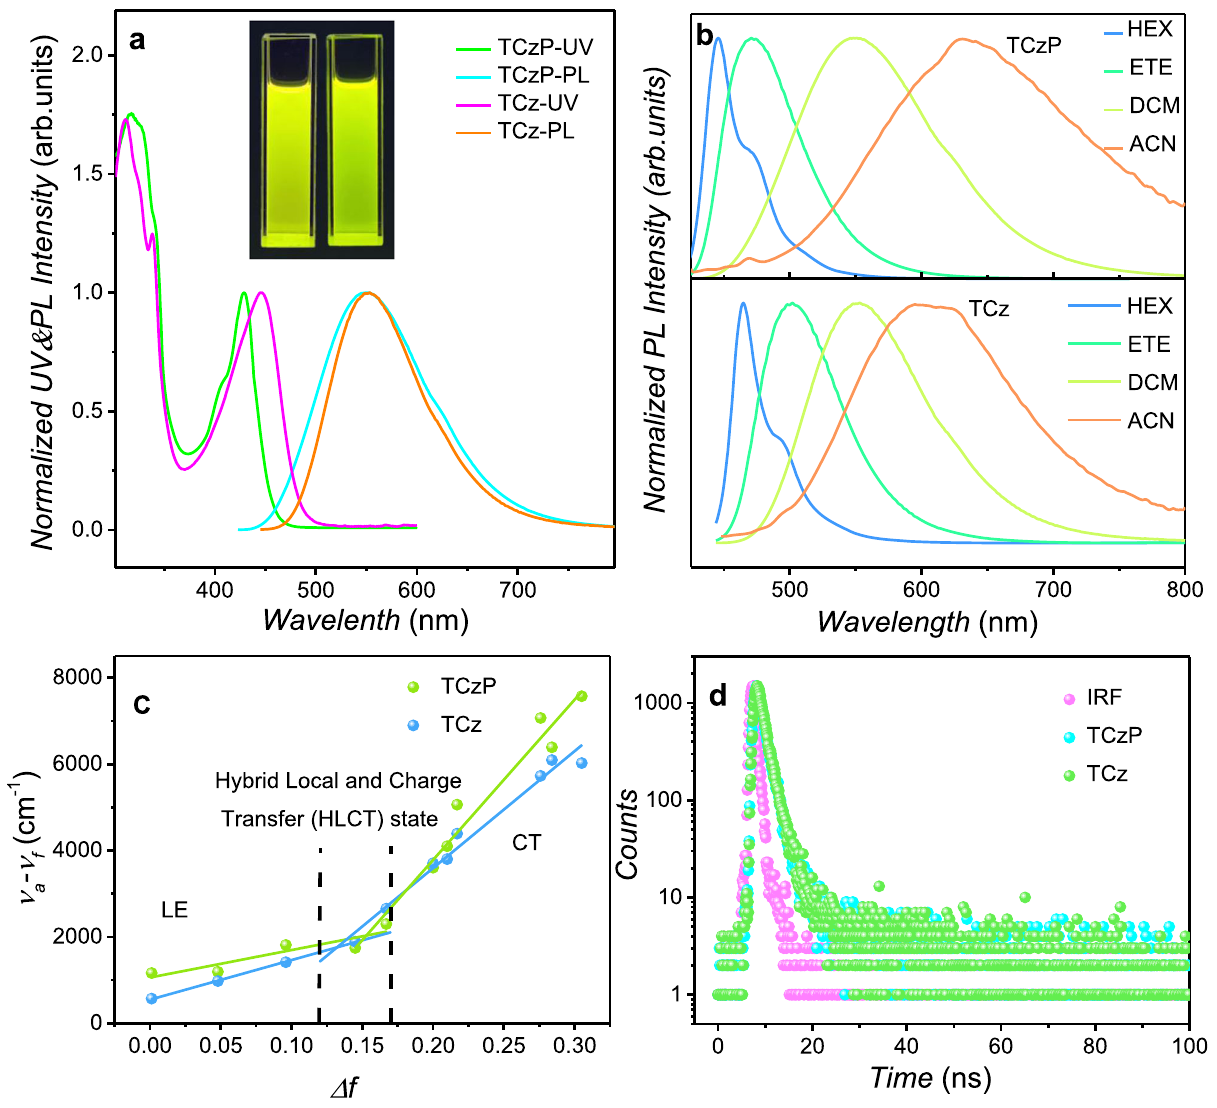
Fig. 1 | Opticalproperties ofpolymerprecursors. a The UV-Vis and PL spectra of TCz and TCzP in DCM. Inset: the photo shows the fl uorescence of TCzP (left) and TCz (right) in DCM solution excited by a wavelength of 365nm. b The